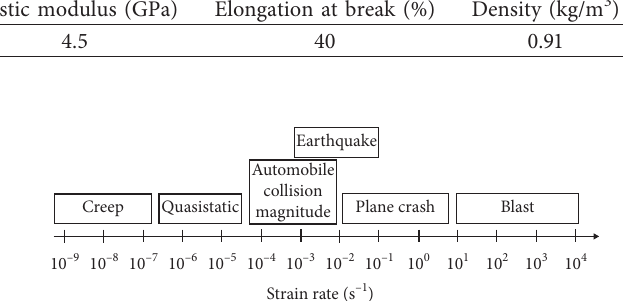
Figure 1: Ranges of strain rate and static/dynamic action.